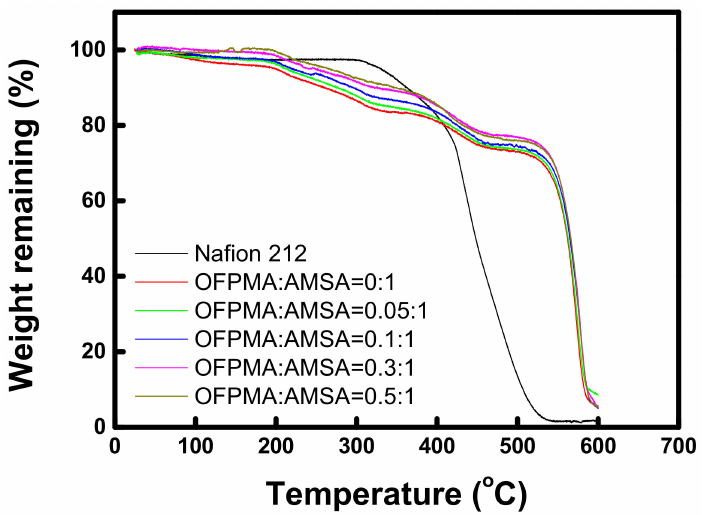
Figure 6. TGA curves of commercial membrane and prepared